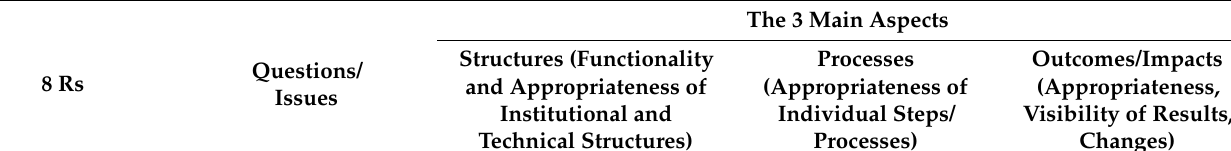
Table 1. 8Rs “responsible” land information management (LIM) aspect and